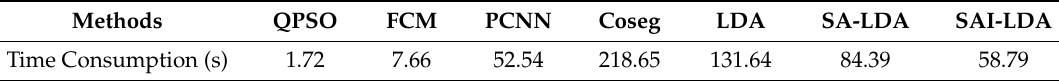
Table 3. Average time consumption between seven algorithms. They are quantum-behaved particle swarm optimization (QPSO), fuzzy c-means clustering (FCM), pulse coupled neural network based segmentation (PCNN), a weakly supervised algorithm co-segmentation (Coseg), the traditional latent Dirichlet allocation (LDA), self-adaptive latent Dirichlet allocation (SA-LDA), and self-adaptive iterative latent Dirichlet allocation (SAI-LDA) (unit: